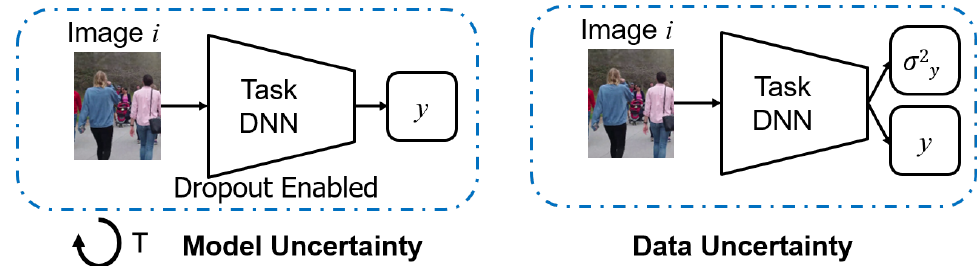
Figure 3. Method for calculating Model and Data Uncertainty in DNN. In model uncertainty, inference is run for T trials with dropout enabled. The sample variance is then computed. In data uncertainty, the variance is computed as a function of the input and the weights of the network. Reprinted with permission from ref. [12]. Coprright 2020